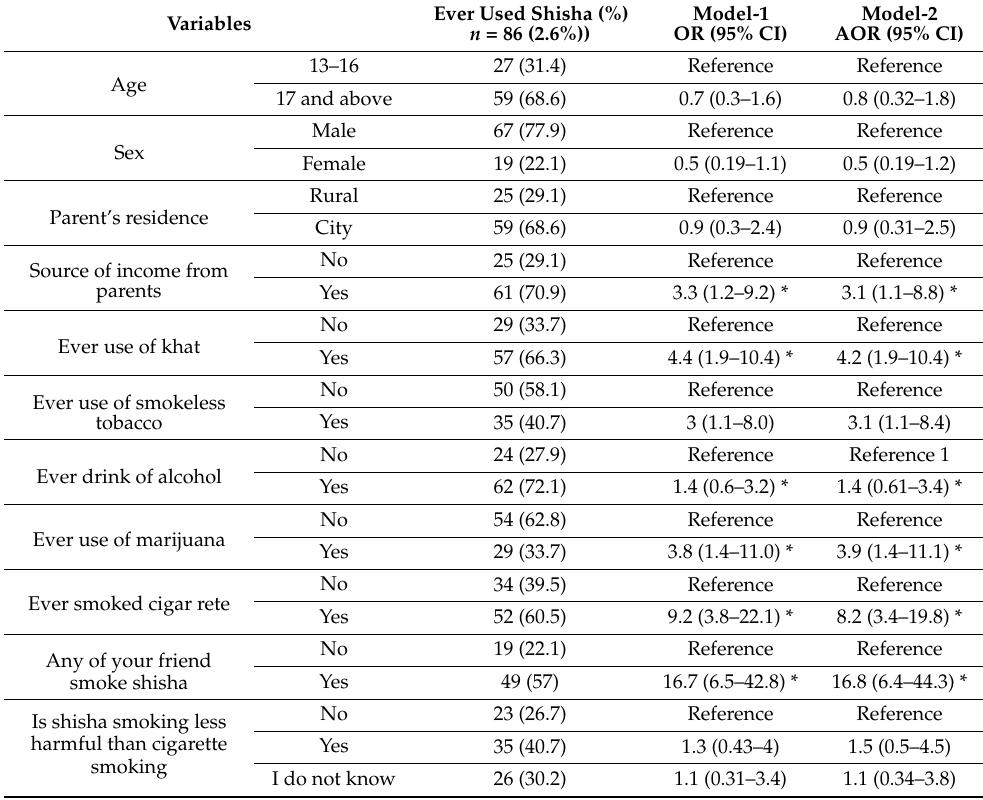
Table 5. Multi-level logistic regression model for ever use of shisha among high school students in